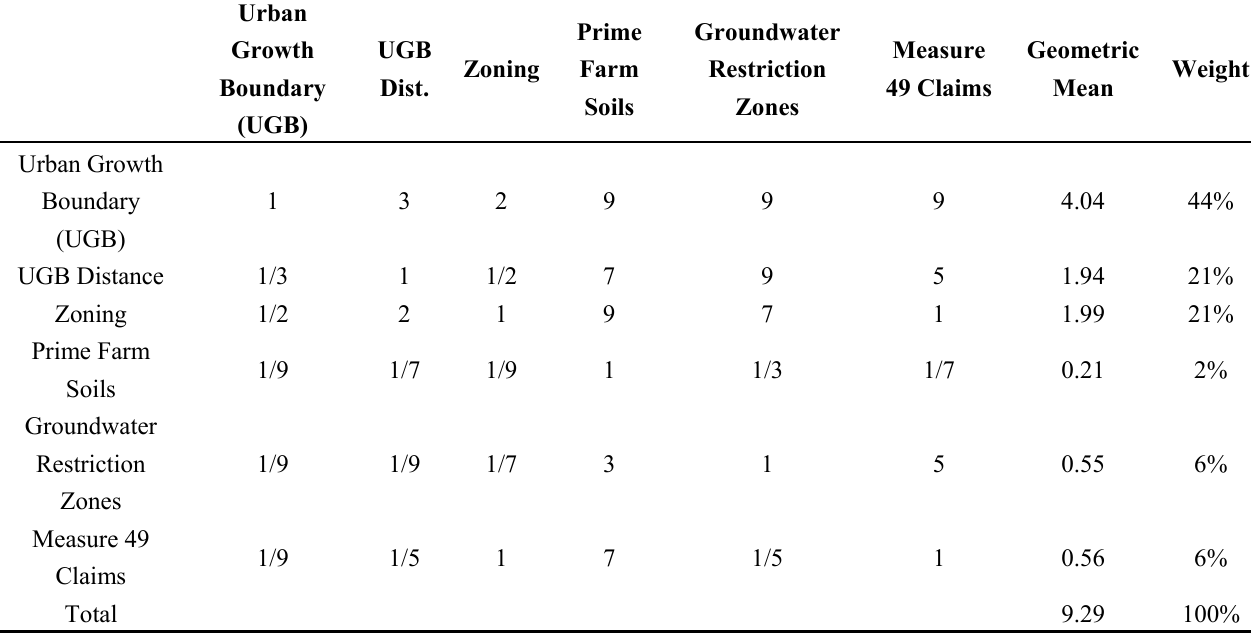
Table 6. Results of the pairwise analytical hierarchy process (AHP) for each spatial variable incorporated into the final graded map that guides the allocation of new urban land cover grid cells in three scenarios of increased